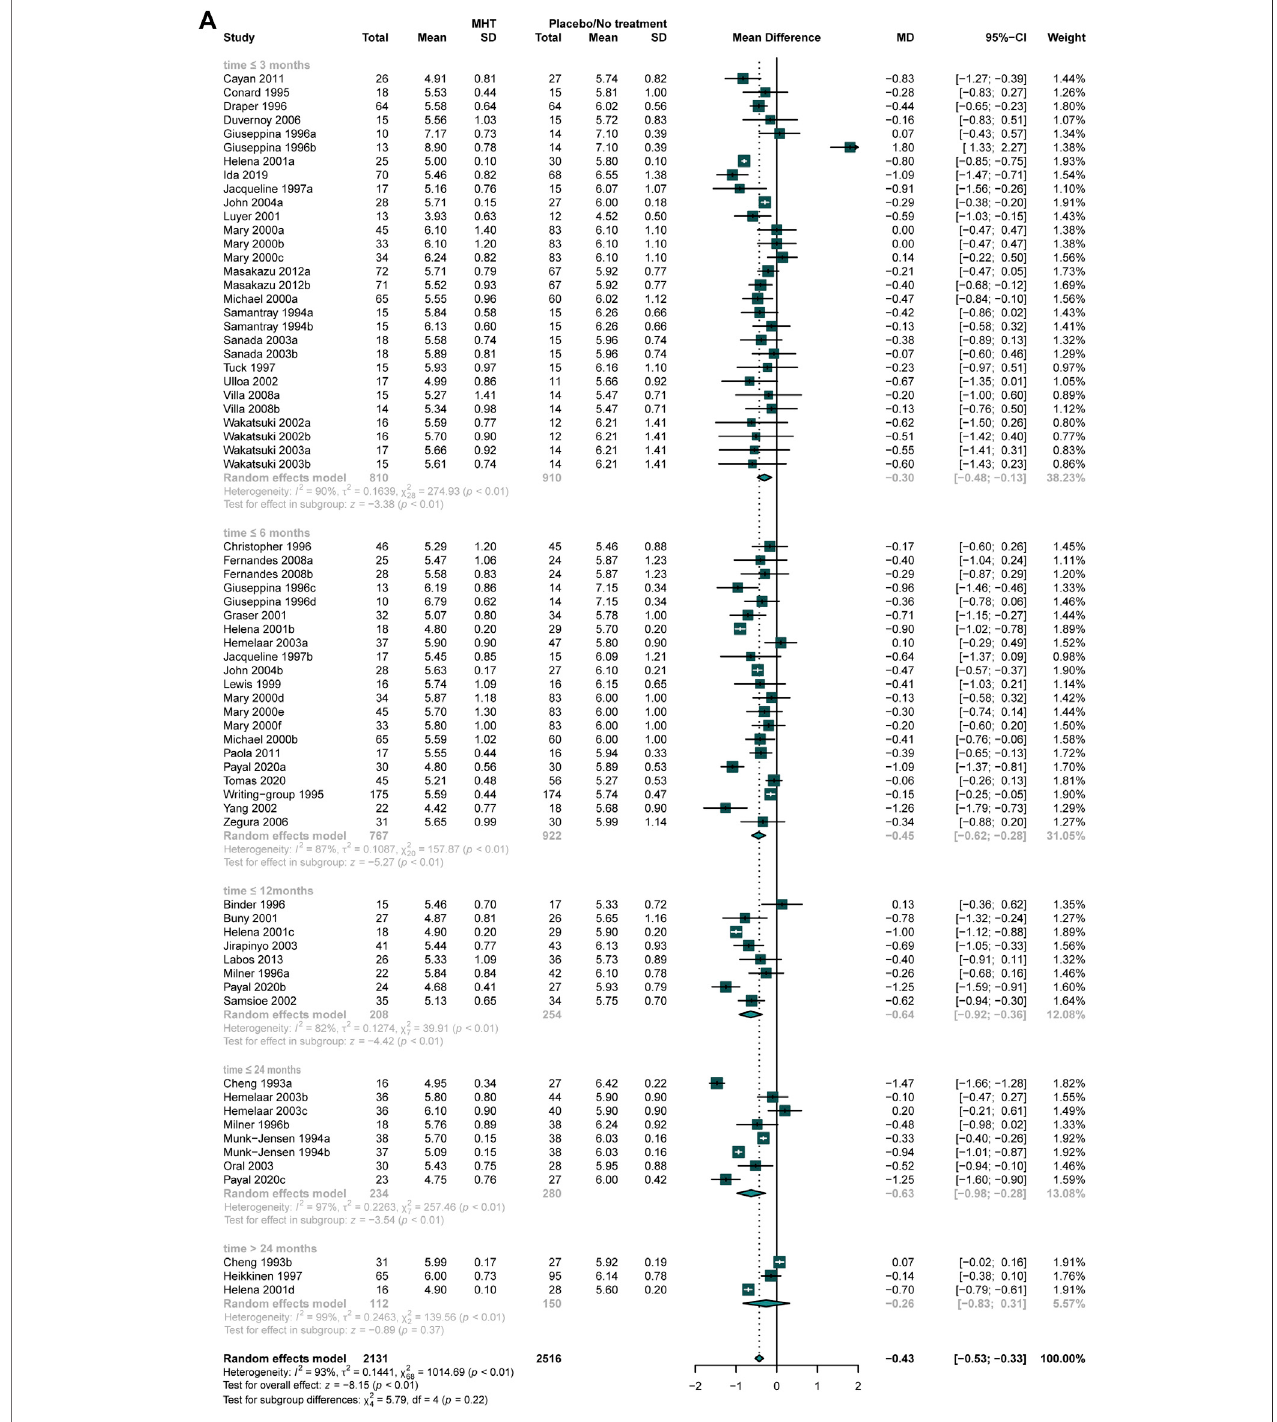
FIGURE 4 | Comparing MHT wih placebo or no treatment. The treatment duration was classi fi ed into the following periods in each lipid index: < 3 months, 3 – 5 months, 6 – 12 months, 13 – 24 months, and > 24 months. MHT led to a signi fi cant reduction in TC concentration, LDL-C concentration and Lp(a) concentration compared with placebo or no treatment. (A) TC concentration; (B) LDL-C concentration; (C) TG concentration; (D) HDL-C concentration; (E) Lp(a) concentration.